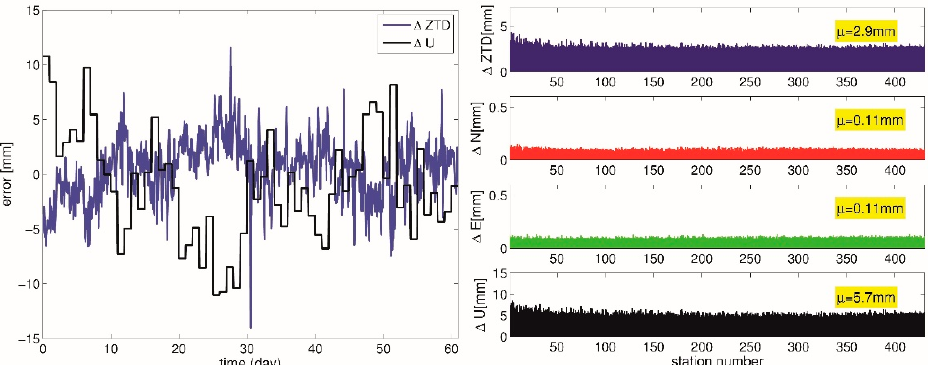
Figure 2. Results for the first simulation experiment. Left panel: the error in the ZTD and the error in the station up-component for the POTS station as a function of time. Right panel: the station-specific RMSE for the ZTD (top), the gradient components (middle), and the station up-component (bottom). The number with yellow background corresponds to the averaged RMSE of the respective parameter.